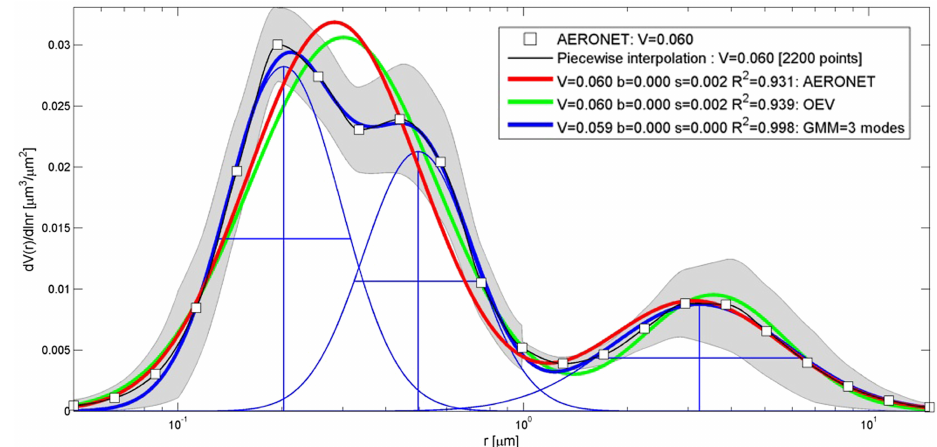
Fig. 7. Comparison of the interpolated AVSD, the AERONET bi-lognormal fit, the OEV bi-lognormal fit and the GMM optimal fit for the daily-averaged AERONET AVSD at Fresno on 11 February 2006 which displays a clear double hump in the fine-mode region. The grey band is the uncertainty on the AERONET